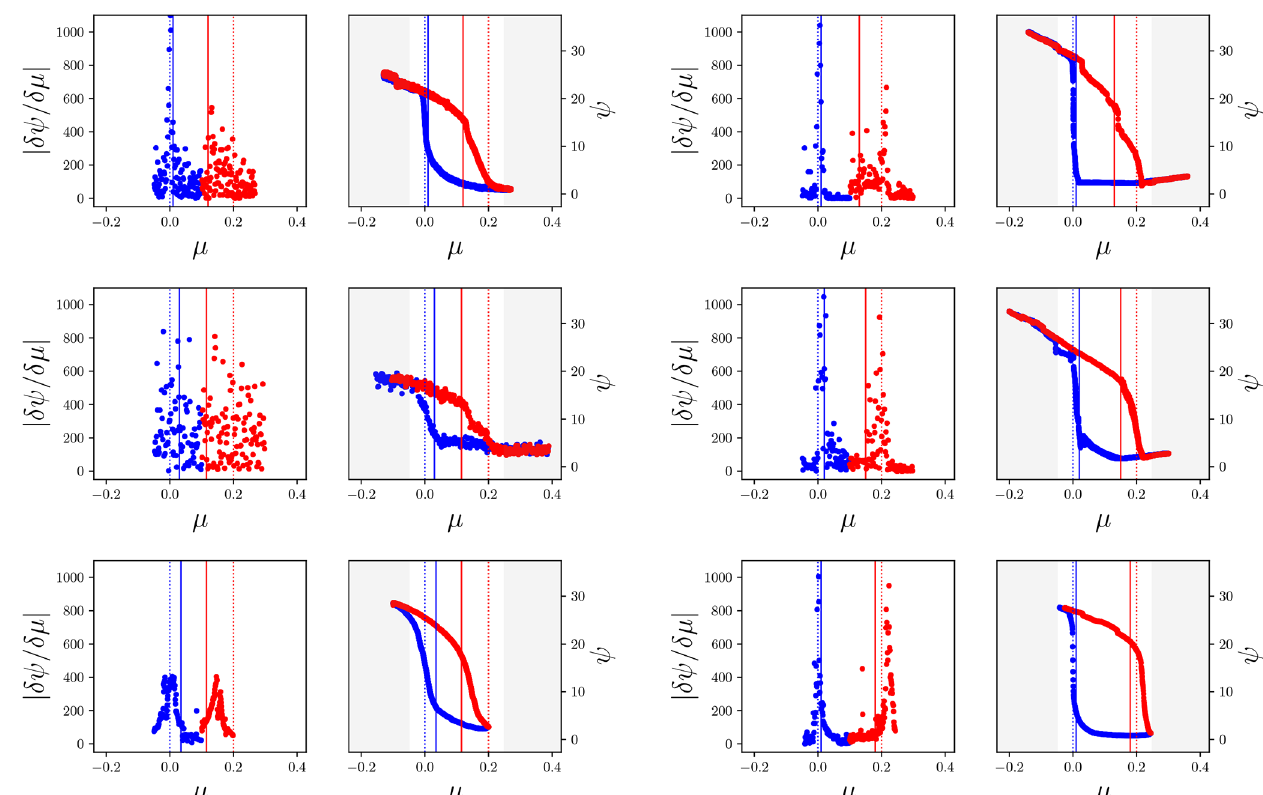
Figure 6. Absolute values of numerical derivatives (left) from the trajectories of AMOC strength as function of freshwater forcing to the right (taken from Rahmstorf et al., 2005, Fig. 2, bottom panel, reproduced with permission from the publisher: American Geophysical Union). In red the upper branch is shown, and in blue the lower branch is shown. The left column shows data from Bremen, ECBilt-CLIO, and C-GOLDSTEIN. The right column shows data from MOM hor, MOM iso, and UVic. Vertical solid lines mark µ = 0 (blue) and µ = 0 . 2 (red); vertical dashed lines mark the chosen boundary values for µ ± . All values are given in units of